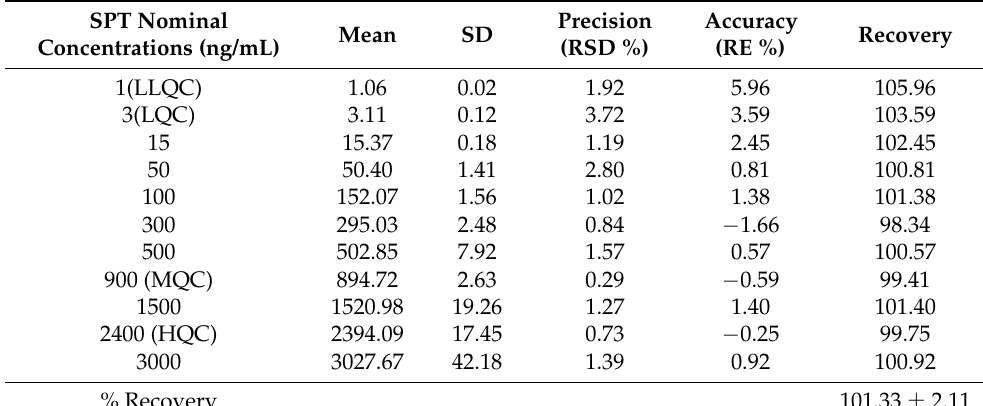
Table 2. Back-calculation data of six repeats (eleven calibration standards and QCs) of SPT.